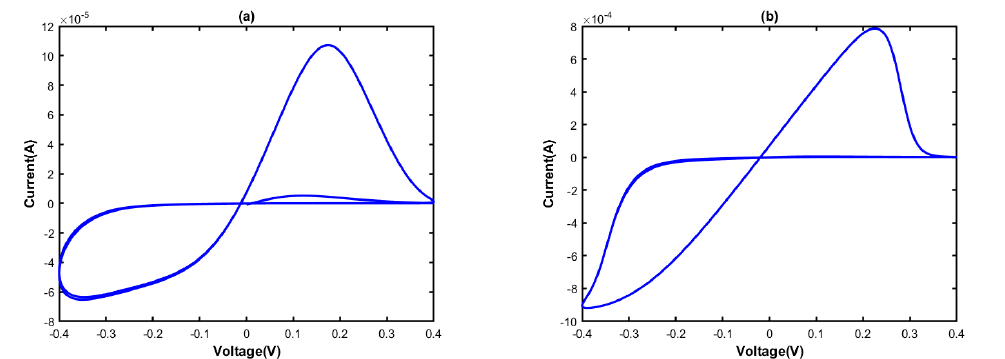
Figure 3. The pinched hysteresis loop of the final design: ( a ) 16 nm and ( b ) 45